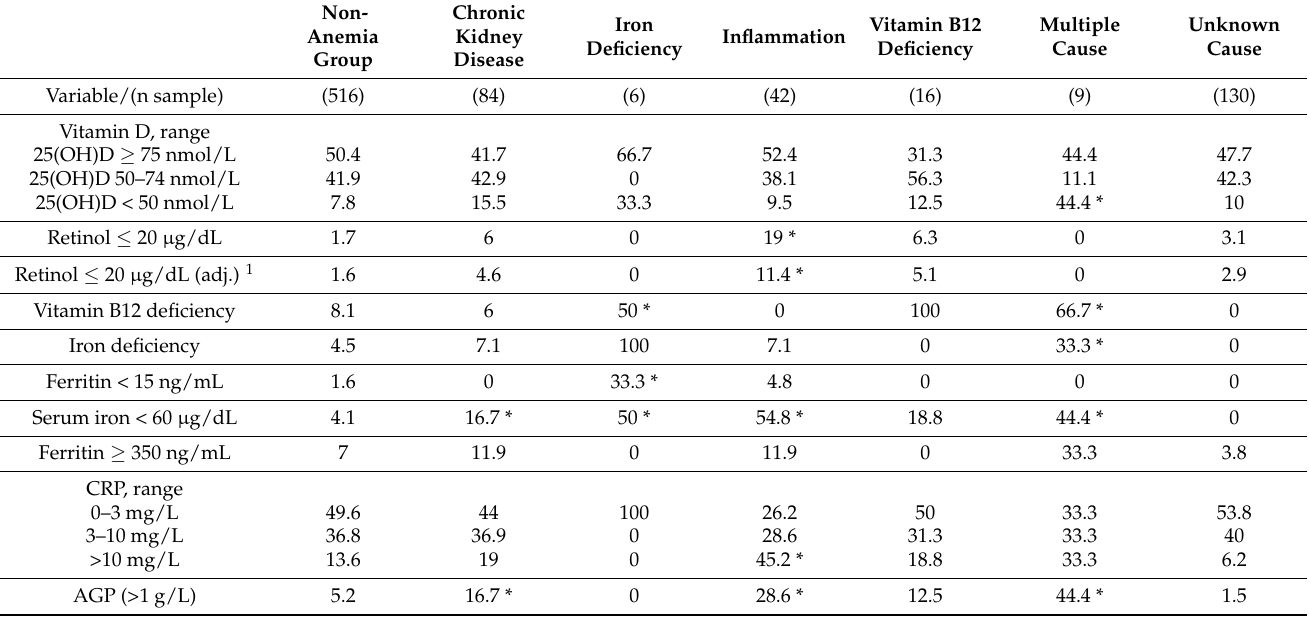
Table 4. Serum biomarkers of older adult study population, by cause of